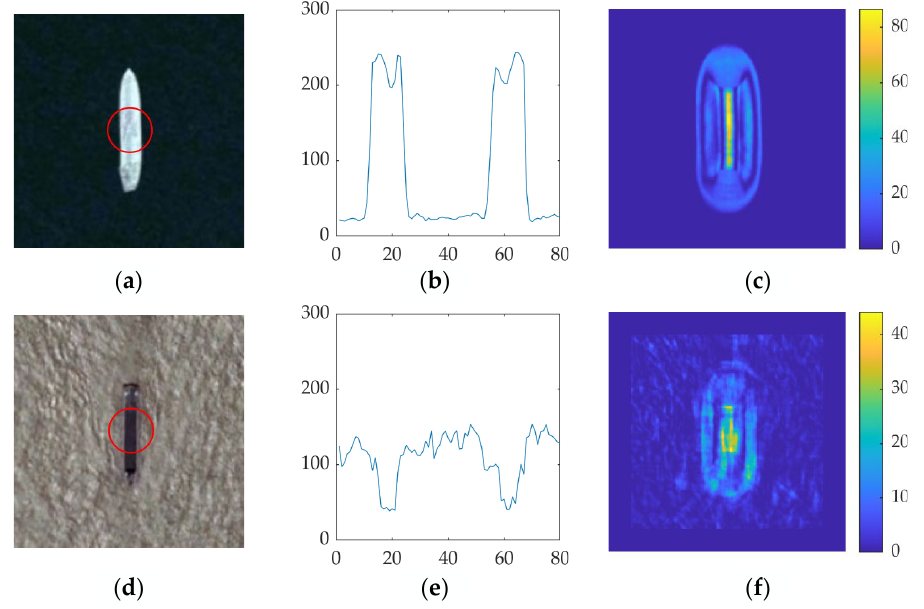
Figure 10. The CF filter along the circle at the target. ( a , d ) Ship Target. ( b , e ) The gray value variation pattern. The horizontal axis denotes the serial number of the 80 sampled points along the circle, and the vertical axis denotes their gray values. ( c , f ) The output using the CF filter.